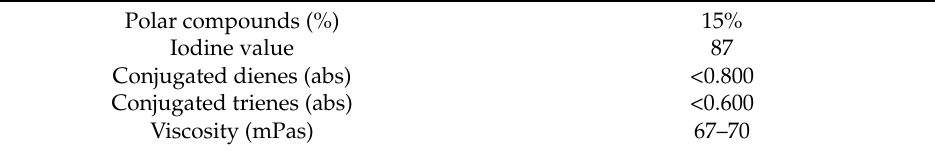
Table 1. Oil frying parameters and limits to change. Polar compounds (%) 15% Iodine value 87 Conjugated dienes (abs) <0.800 Conjugated trienes (abs) <0.600 Viscosity (mPas) 67–70